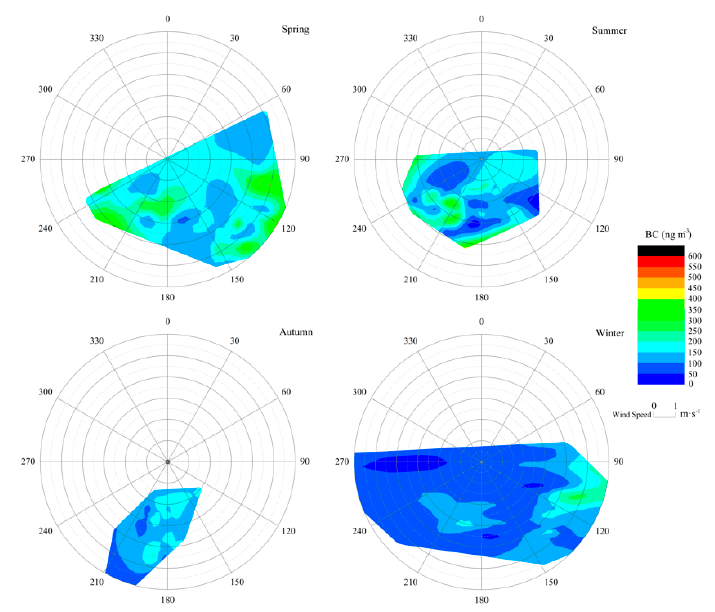
Figure 4. The relationship of average BC concentration and winds during the study period.